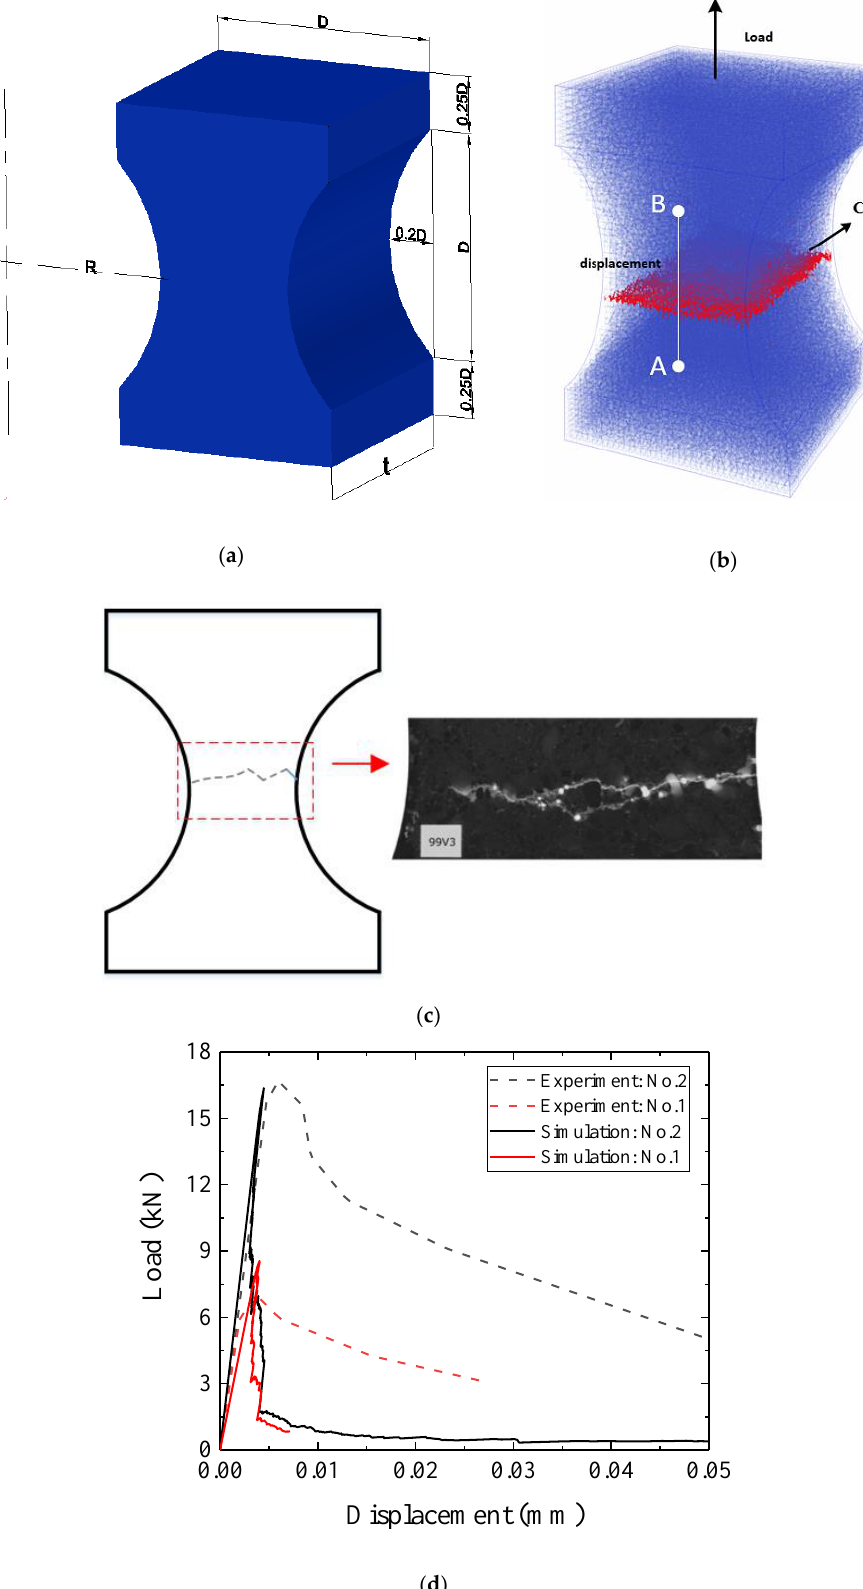
Figure 3. ( a ) Setup for uniaxial tensile test, ( b ) failure mode for uniaxial tensile test (red-cracked element), ( c ) failure mode for uniaxial tension test in the experiment [46]. Reproduced from [46]. Copyright 2003, Elsevier. ( d ) typical load-displacement curve for direct tensile tests